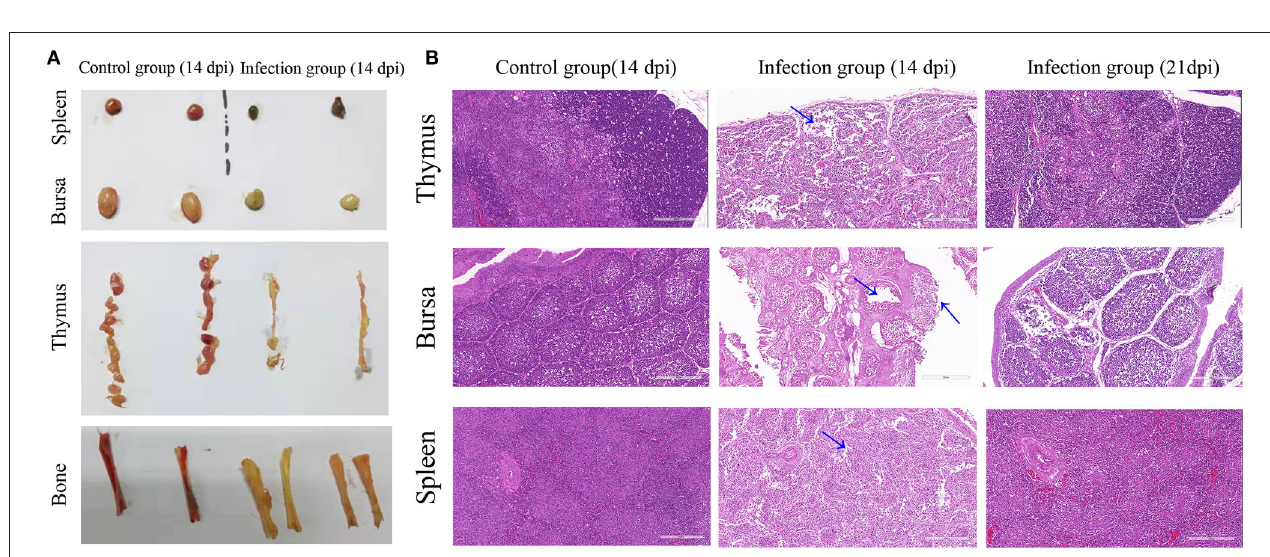
FIGURE 4 | Gross lesions and histopathological changes. (A) Representative images of the macroscopic appearance of the spleen, bursa, thymus, and bone in the control group and infection group. (B) Thymus, bursa, and spleen tissues from an uninfected chicken (14 dpi) and CAV-infected chickens (14 dpi and 21 dpi). Histopathological changes are indicated by blue arrows. Hematoxylin and eosin (HE) staining, scale bar: 200 µ